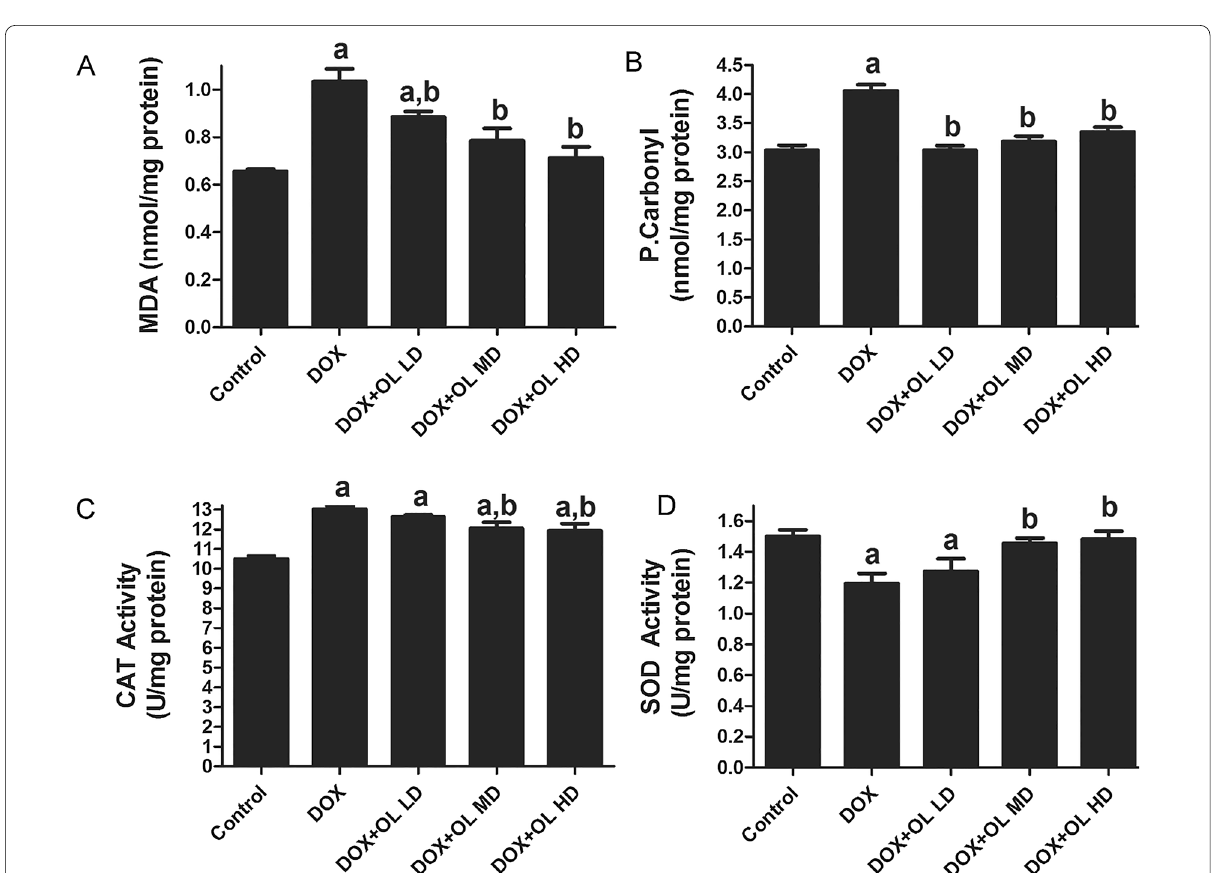
Fig. 2 Effect of OL on MDA level ( a ) and P.Carbonyl content ( b ) in heart tissues of control- and DXR-treated rats. Each column represents the mean SEM ( n 6). Significance was determined by one-way analysis of variance followed by Dennett’s t-test: a P < 0.05 versus control group, b ± = P < 0.05 versus DOX